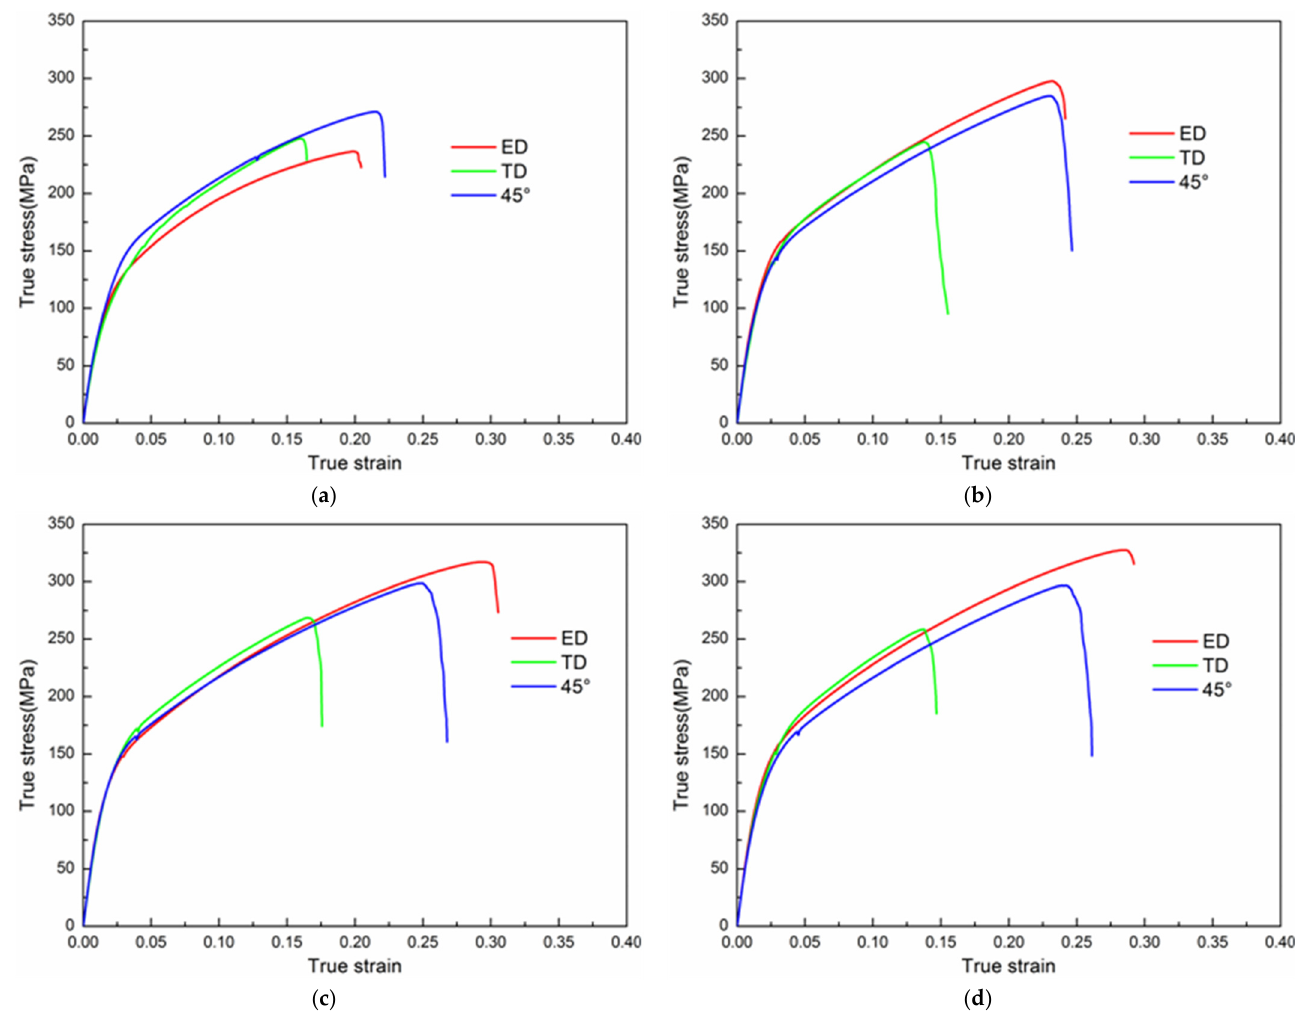
Figure 9. Typical true stress–strain curves of as-extruded sheets: ( a ) alloy 1, ( b ) alloy 2, ( c ) alloy 3, and ( d ) alloy 4. and ( d ) alloy 4. Table 4. Tensile properties of the alloys at room temperature (RM). Table 4. Tensile properties of the alloys at room temperature